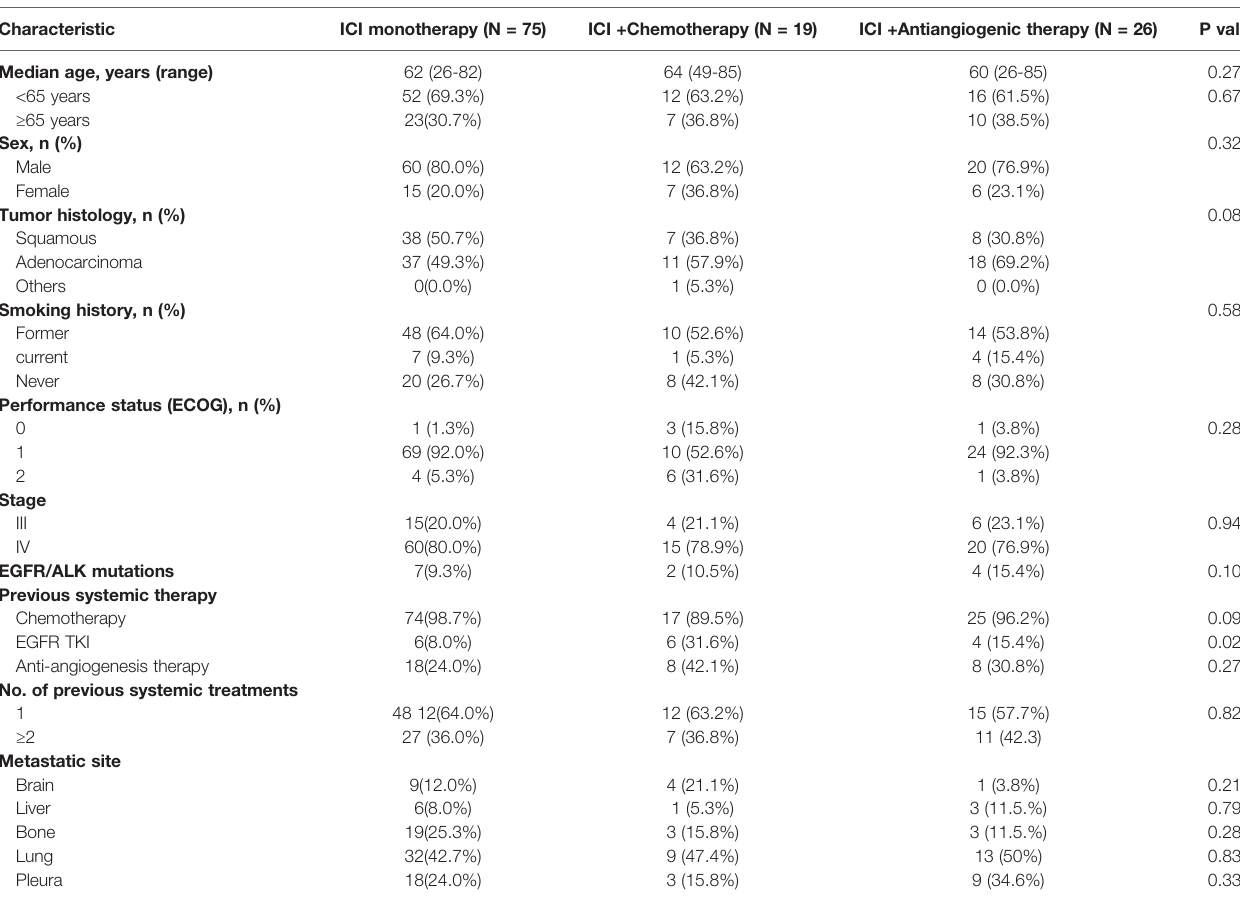
TABLE 1 | Patient